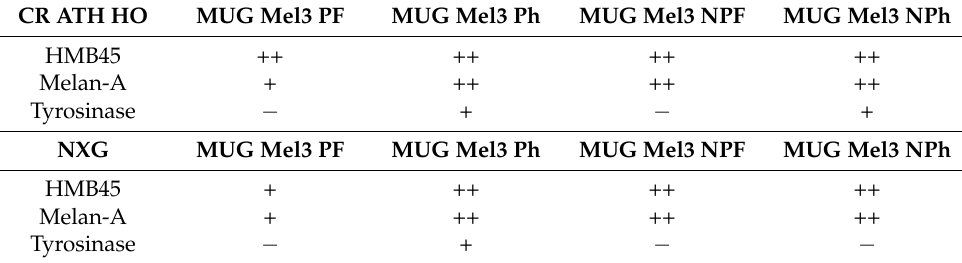
Table 2. Overview of melanoma markers expressed in xenografts.